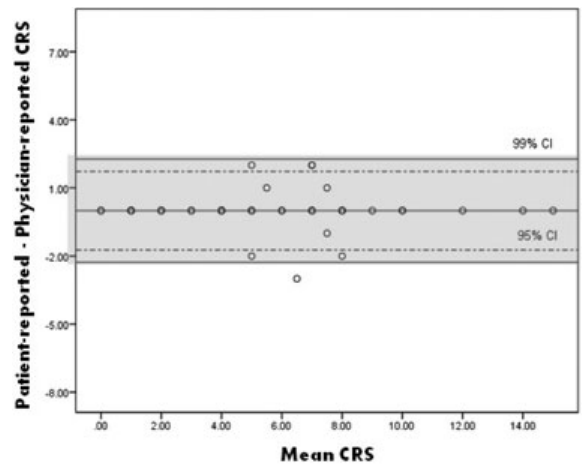
Fig. 3 Bland – Altman for patient-completed Caprini risk